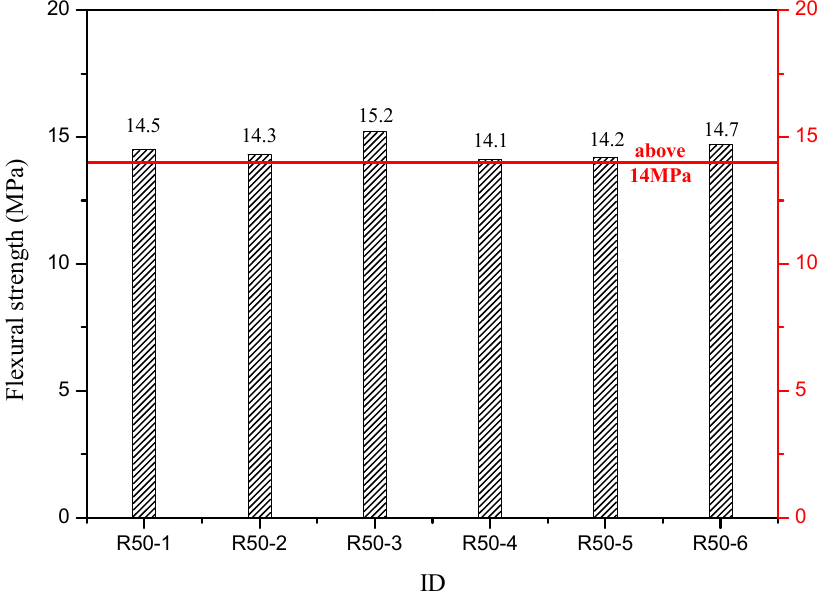
Figure 10. Flexural strength of panel type specimens.